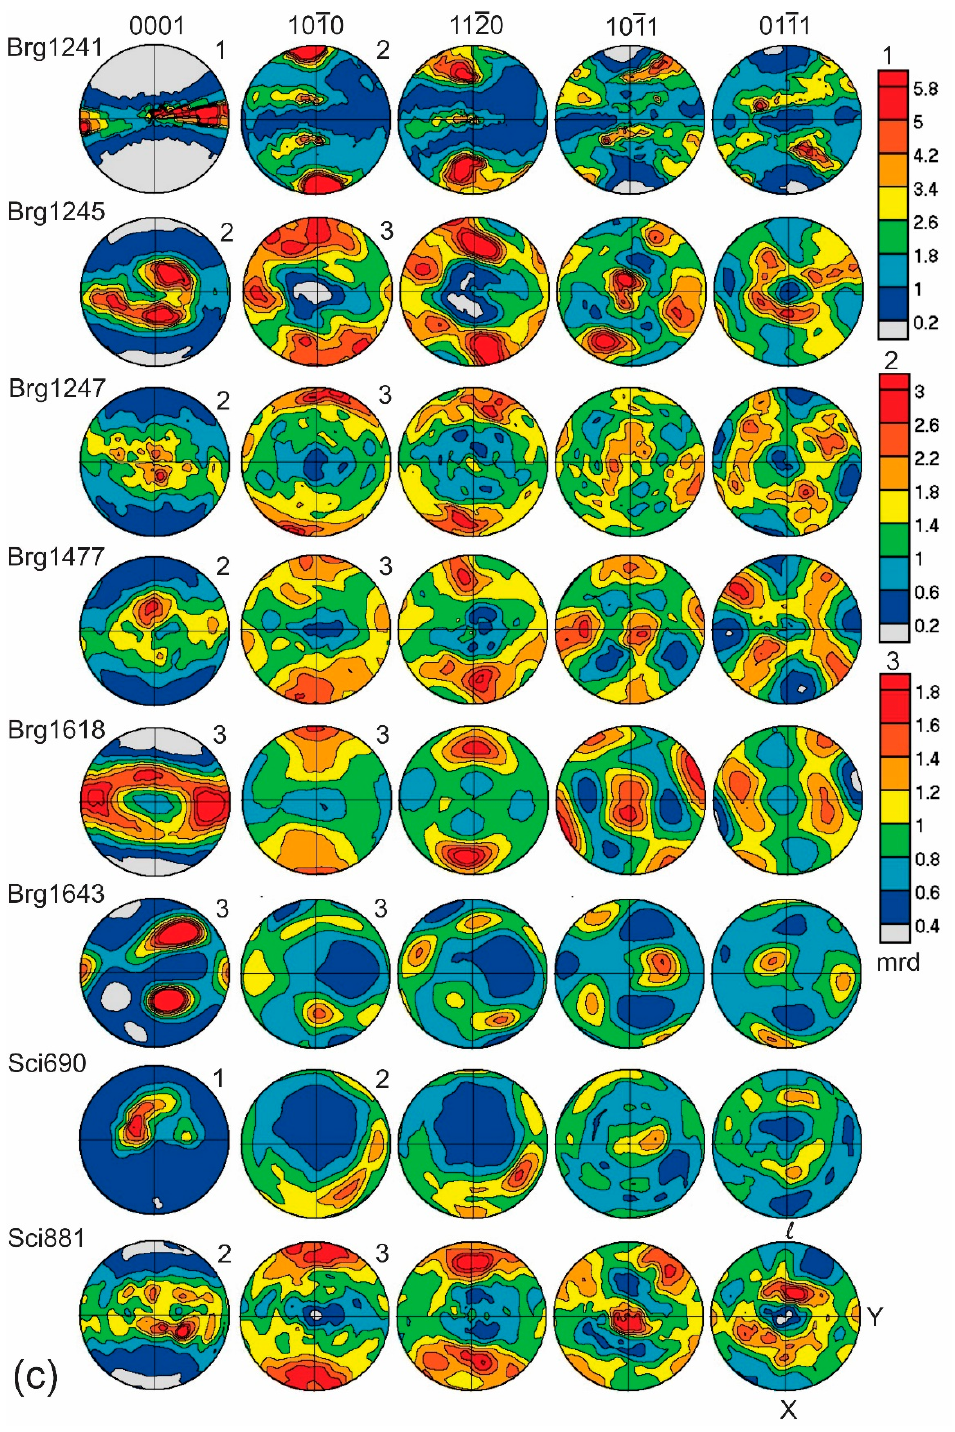
Figure 7. Neutron pole figures for quartz of Triassic quartzites. Equal area projection on the schistosity plane. Lineation is l . Numbers on top right of pole figures indicate which pole density scale was used (in mrd). The scale in the second column was also applied to Columns 2–5. The order of samples is the same as in Table 1. 24 Triassic quartzites are divided on three figures ( a ), ( b ), ( c ).